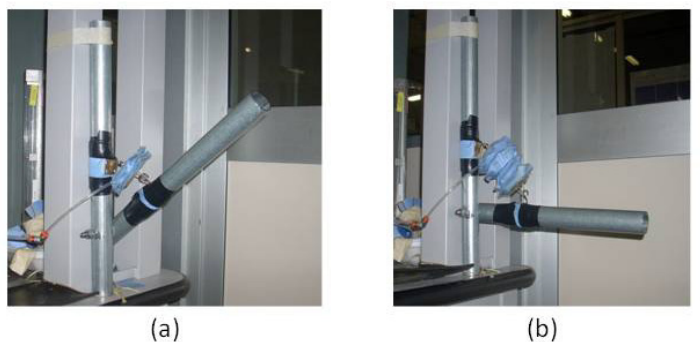
Figure 16. Application of a bellows muscle to an arm simulator: ( a ) bellows muscle w/o supply; ( b ) pressurized bellows